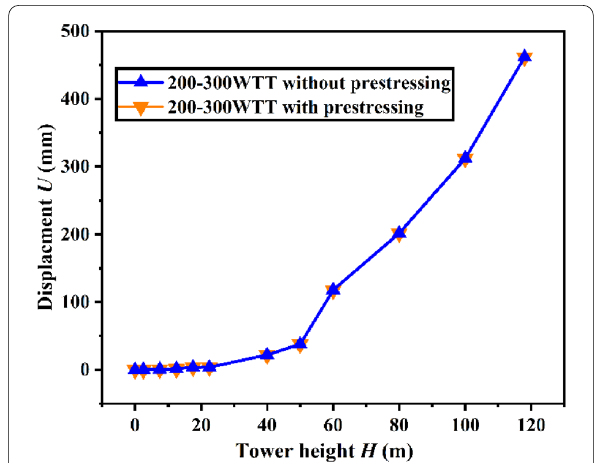
Fig. 12 Displacement distributions of UHPC segment in towers with and without